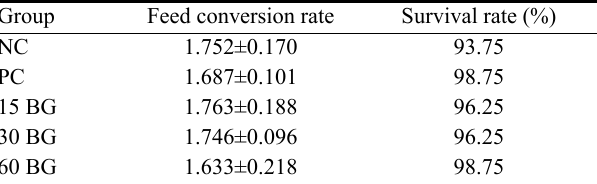
Table 3. Effect of β-glucan on the feed conversion rate and